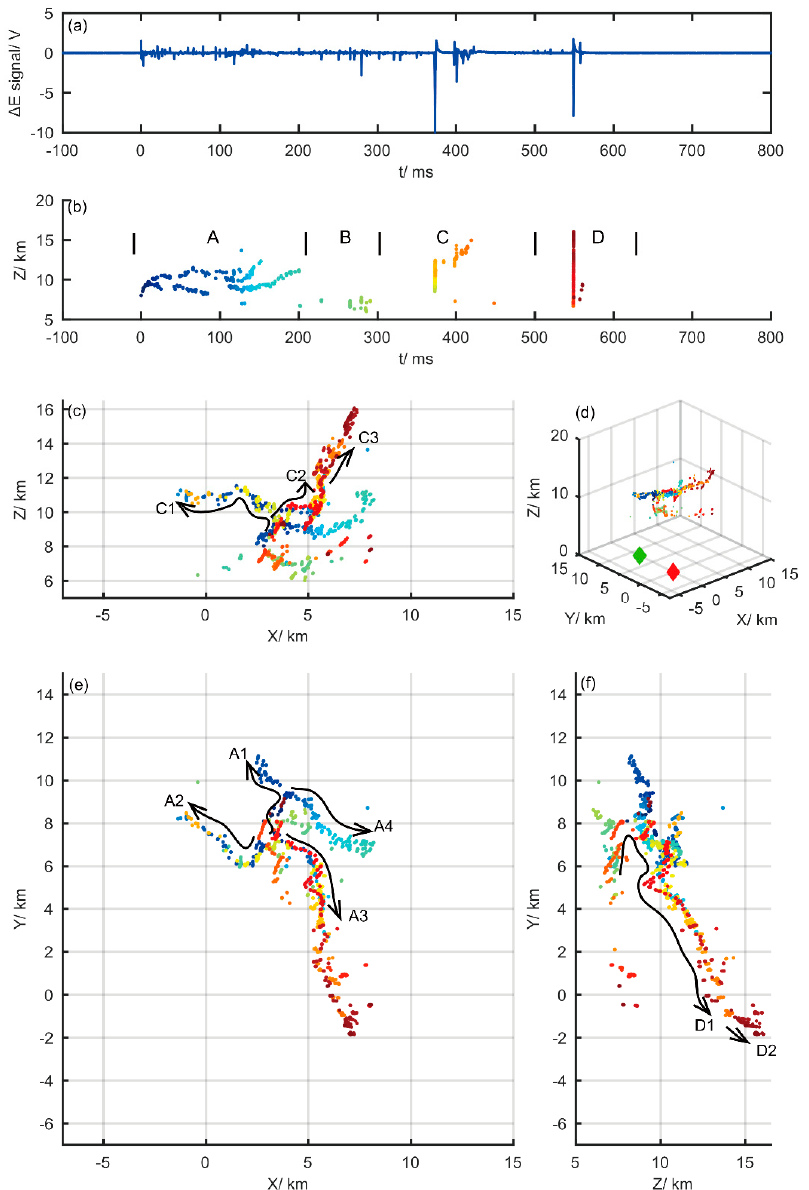
Figure 5. The 3-D locating results of an IC flash. ( a ) The fast electric field change waveform observed by site A; ( b ) the change of the radiation source height with time; ( c ) the projection of the 3-D locating result on the X-Z plane; ( d ) 3-D locating result and the two observation sites ( e ) the projection on the X-Y plane; ( f ) the projection on the Y-Z